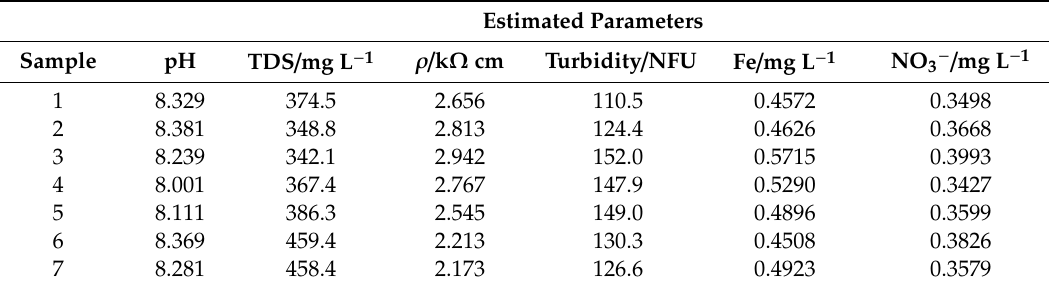
Table 5. Results of PLS1 regression models.